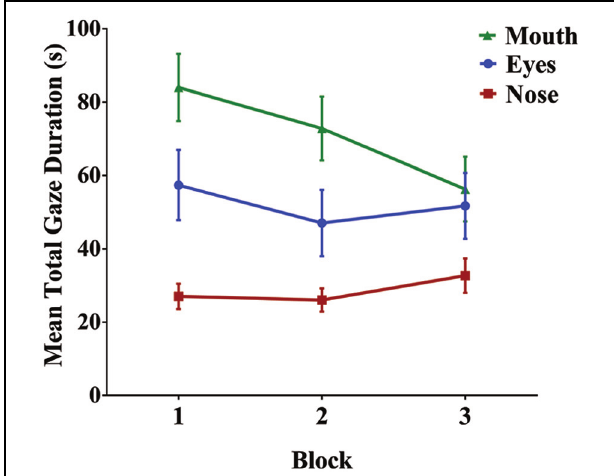
FIGURE 5 | Mean total gaze duration for each facial region across the three familiarization blocks. As familiarization progressed, there was a significant decrease in gaze duration on the mouth, but not for the eyes or nose. Error bars denote ± 1 SEM.